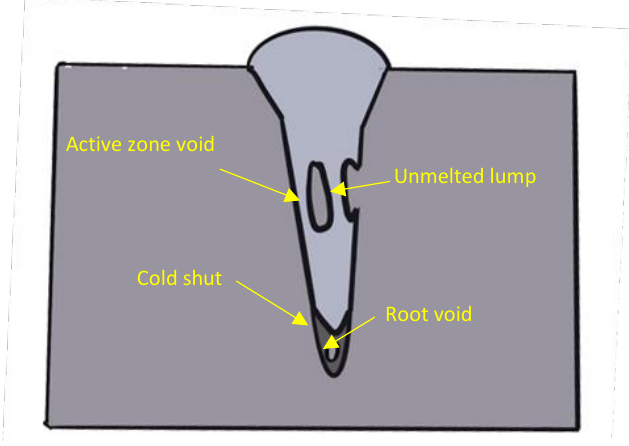
Figure 3: Schematic of EBW defects